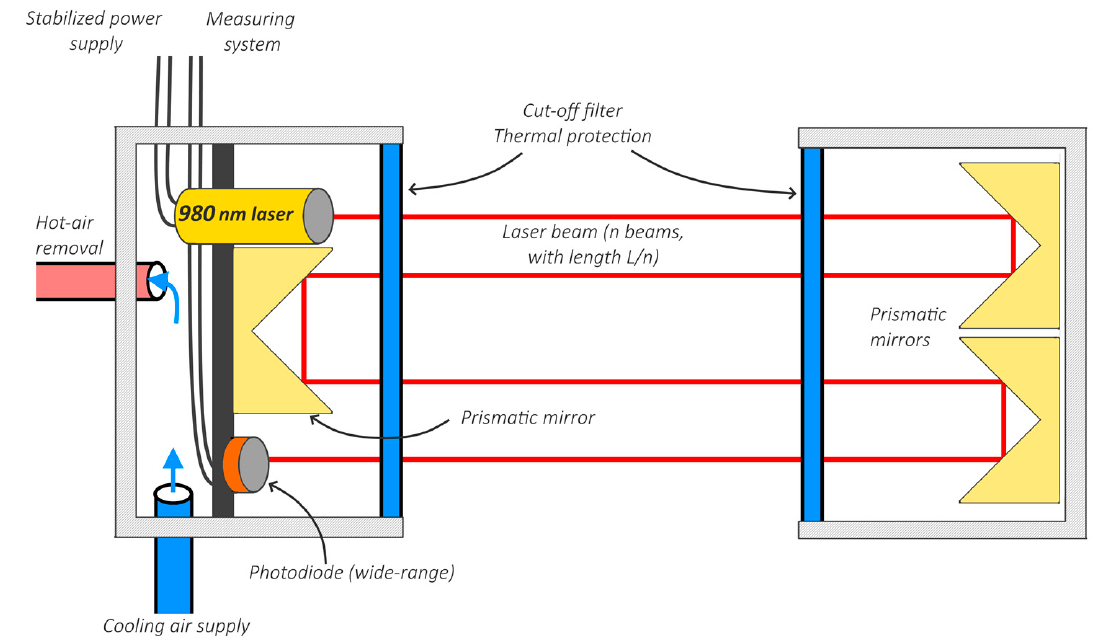
Figure 3. Dividing the optical path with a length of l into n beams with a length of l / n , to measure the transmittance in the reduced-scale model as in the full scale, based on Equations (14) and (16).